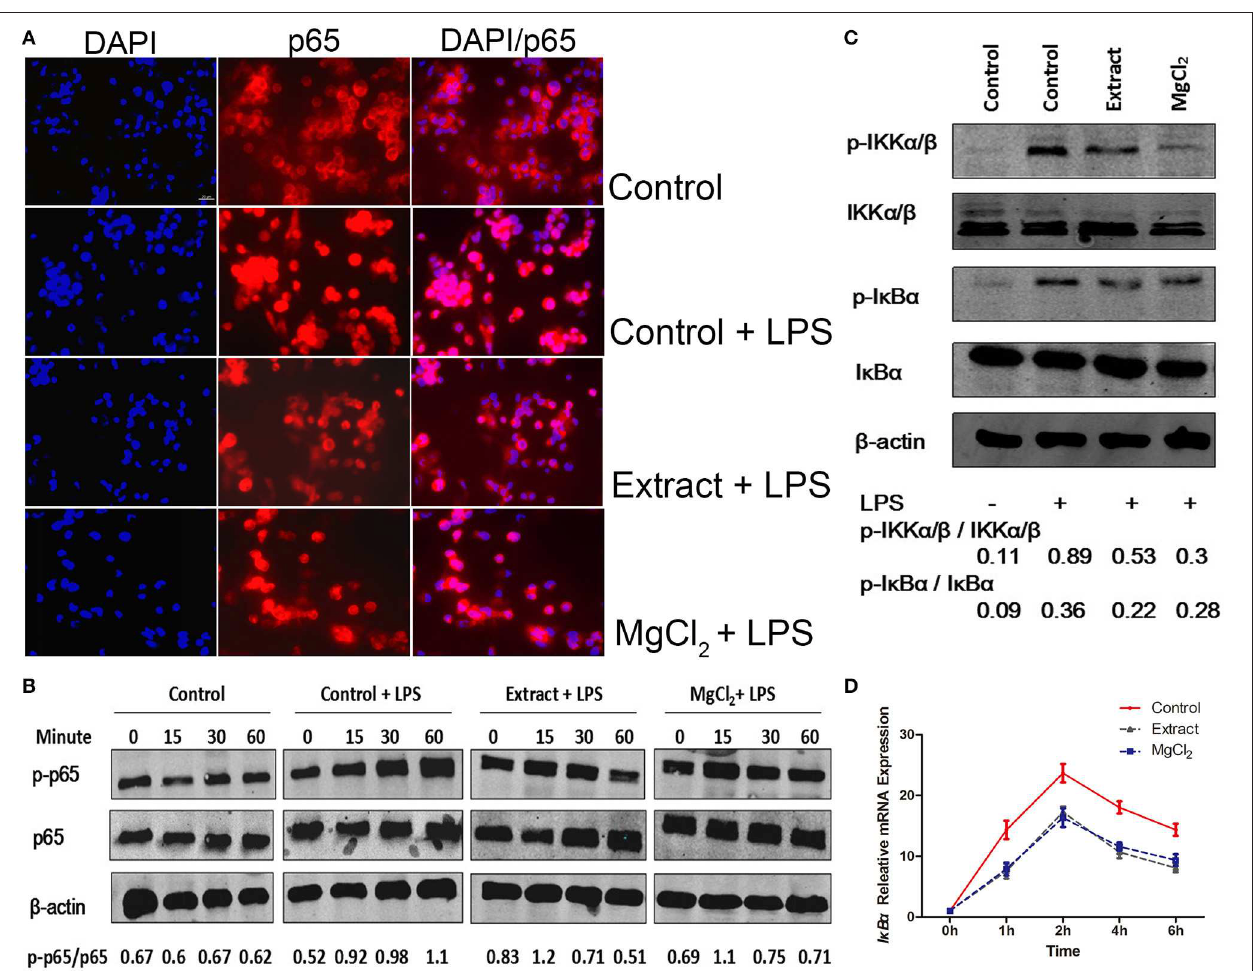
FIGURE 6 | Effects of extract and MgCl 2 on the NF- κ B inflammatory signaling pathway in LPS-induced THP-1 cell-derived macrophages. Cells were pretreated with extract or MgCl 2 for 1h and then stimulated with LPS for 30min. (A) Immunofluorescence images of control, LPS + control, MgCl 2 + LPS, and extract + LPS groups. Scale bar = 20 µ m. (B) The p65 activity in THP-1 cell-derived macrophages was determined at the indicated times by western blotting. (C) Cells were pretreated with extract or MgCl 2 for 1h and then stimulated with LPS for 30min. The relative expression of p-IK β - α /IK β - α and p-IKK- α / β /IKK- α / β was determined by western blotting. (D) THP-1 cell-derived macrophages were pretreated with extract or MgCl 2 and then stimulated with LPS at various time points. The increase in LPS-induced I κ B- α gene expression was in the presence of extract or MgCl 2 analyzed by qPCR. The representative images from three experiments are shown. NF- κ B, nuclear factor-kappa B; LPS,